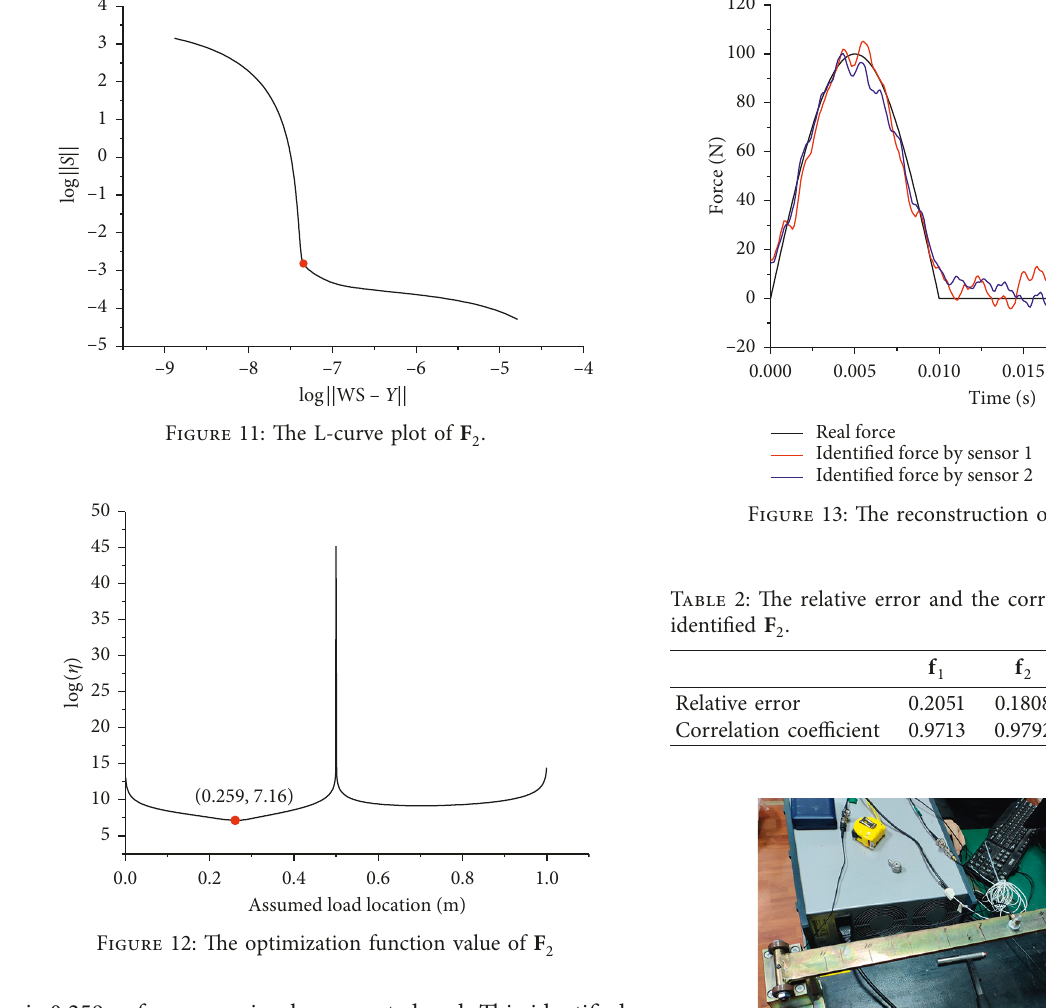
Figure 12: The optimization function value of F